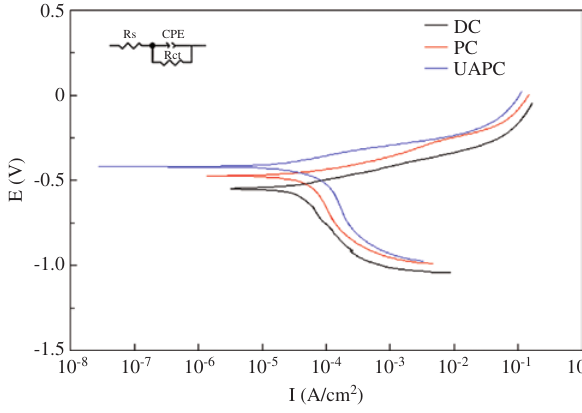
Figure 8 Polarization curves of Ni-AlN thin films deposited by (A) DC, (B) PC, and (C) UAPC methods.